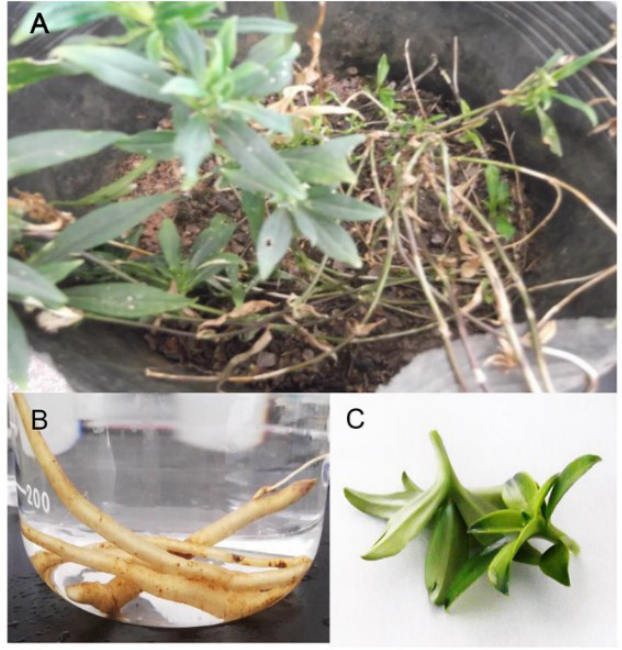
Figure 11. Plant materials of G. rigescens . ( A ) G. rigescens used in this article; ( B , C ) are roots and leaves used in experiments for